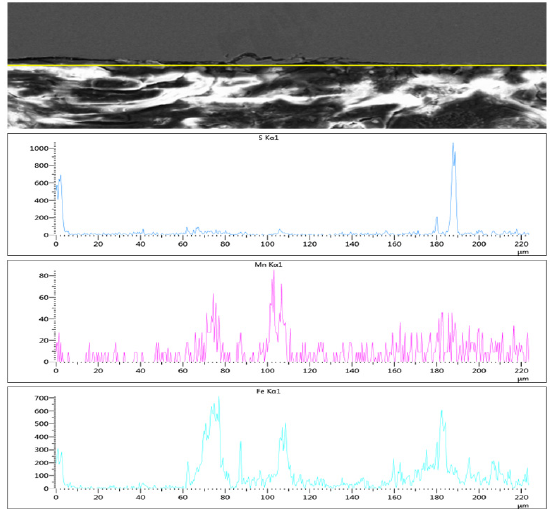
Figure 12. Wear morphology ( a ) and EDS elemental maps ( b – g ) of SLD-MAGIC under a normal load of 40 N.